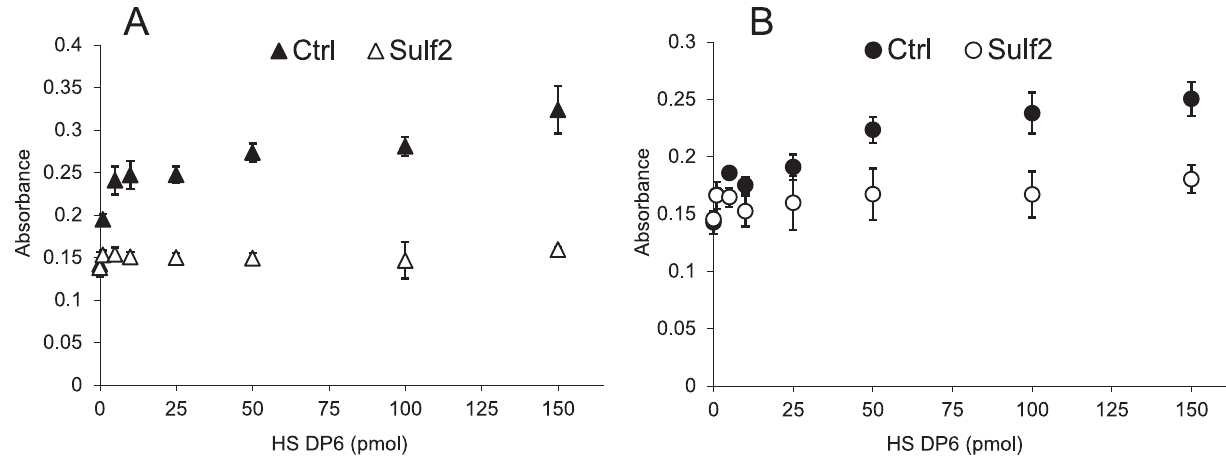
Figure 3. Dose-response plotting of BaF32 cell proliferation assays of two different HS DP6 sources upon HSulf2 digestion. A. HS DP6 from lyase III digestion. B. HS DP6 from lyase I digestion.